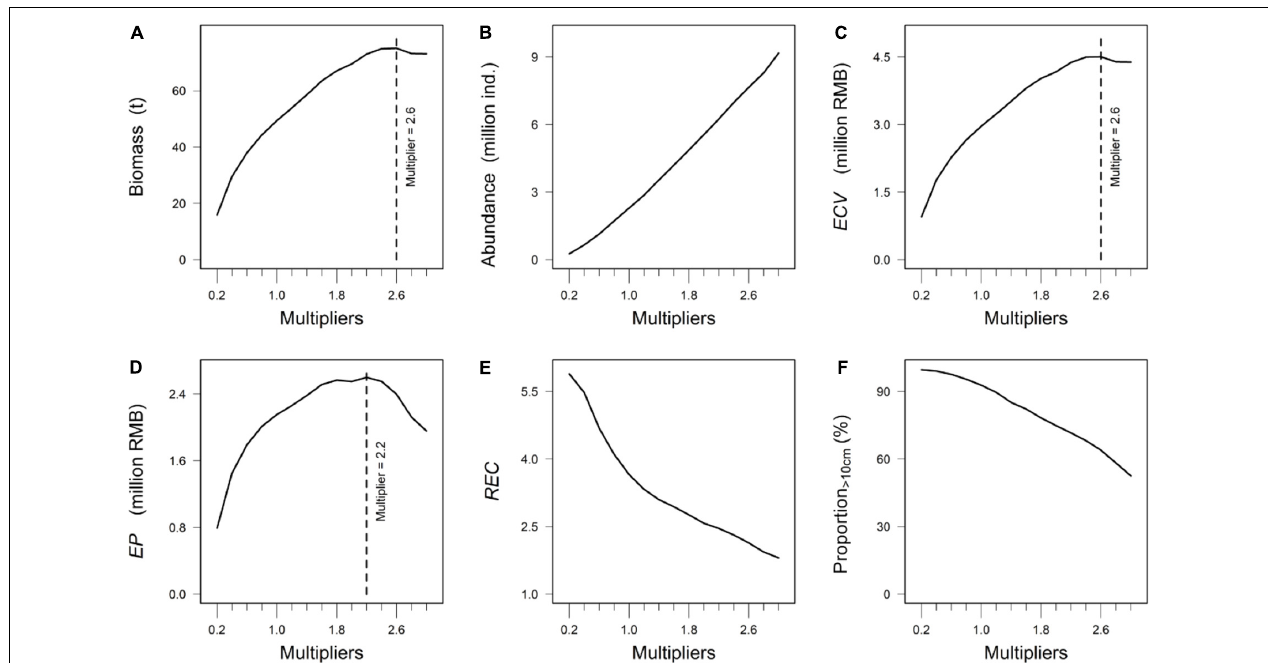
FIGURE 4 | The outputs of estimated biomass, abundance, and commercial value ( ECV ) in S1 were shown on the top (A–C) . The outputs of economic profit ( EP ), ratio of estimated commercial value ( ECV ) and charge of releasing F. chinensis ( Cost ) ( REC ), and proportion of individuals larger than 10 cm at the end of August in S1 were shown on the bottom (D–F) . The calculation of indicators were shown in Table 2 .